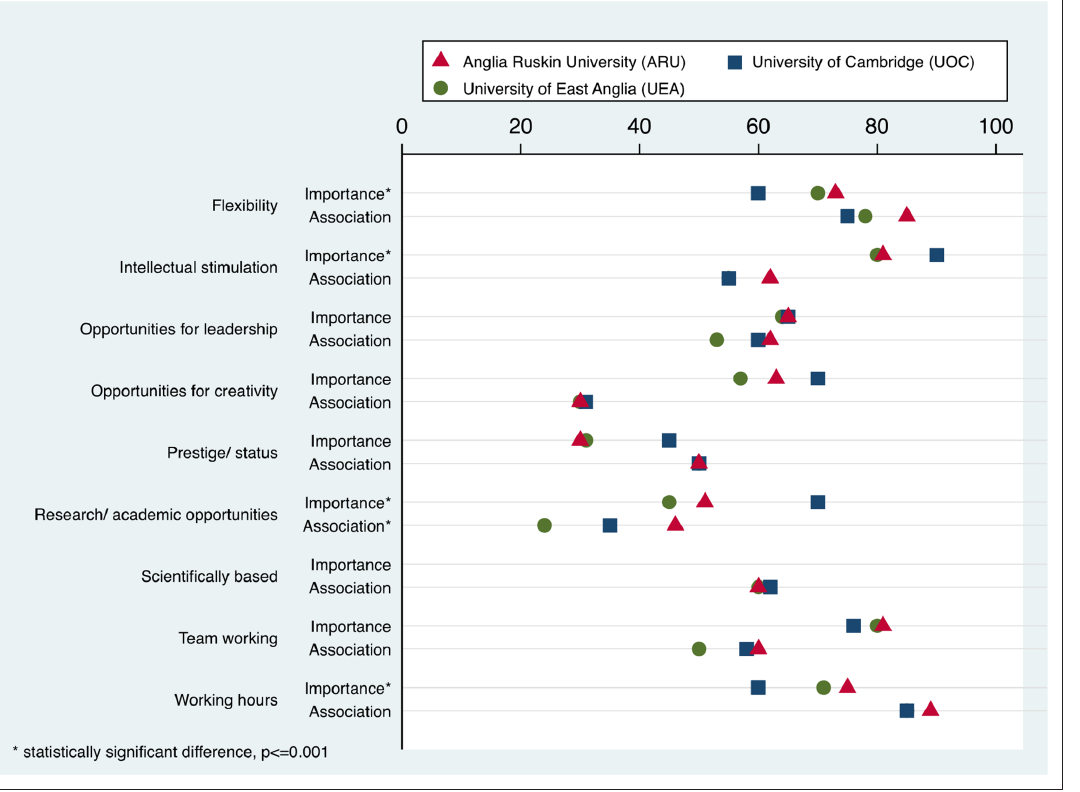
Figure 1 Importance of career factors and degree to which they were associated with general practice. Where only two shapes are evident this is because the third is obscured by another which has the same